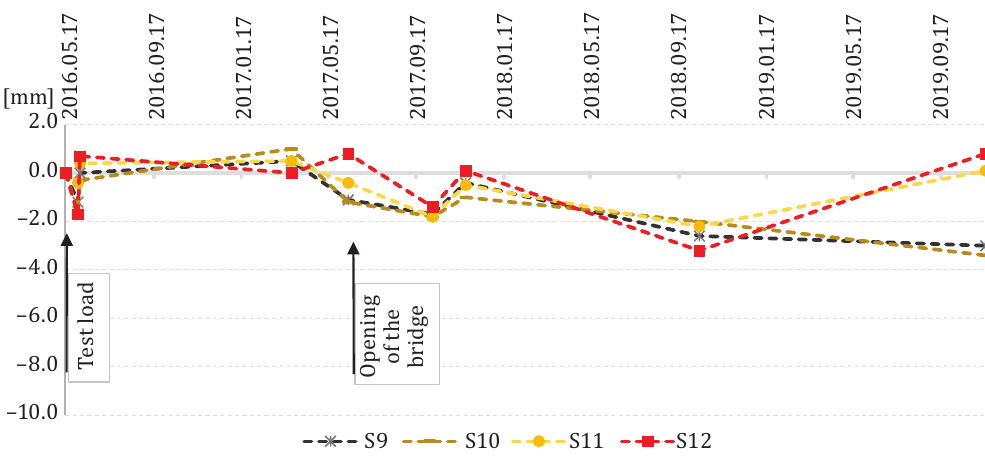
Figure 11. Horizontal displacements (in mm) of control points S9, S10, S11, S12 within 3.5 years from starting test